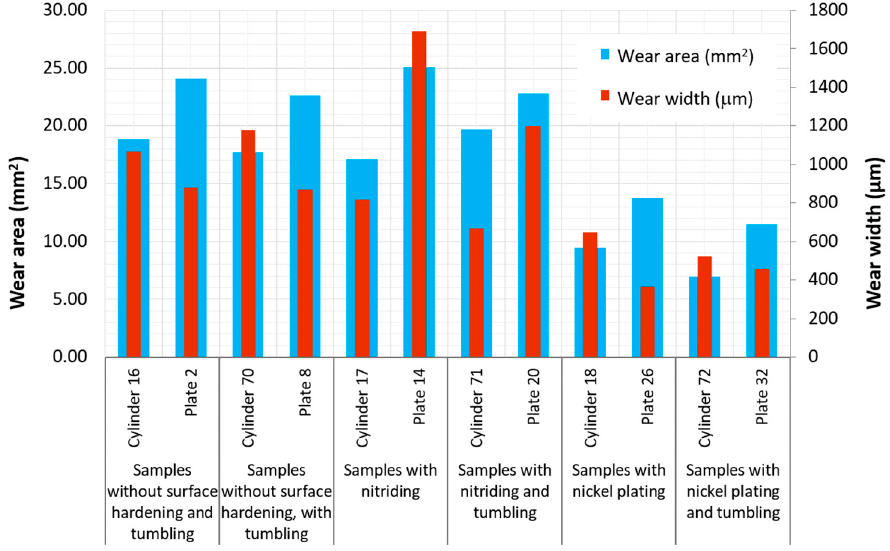
Figure 27. Frequency load (all samples of configuration Cylinder/Plate together).